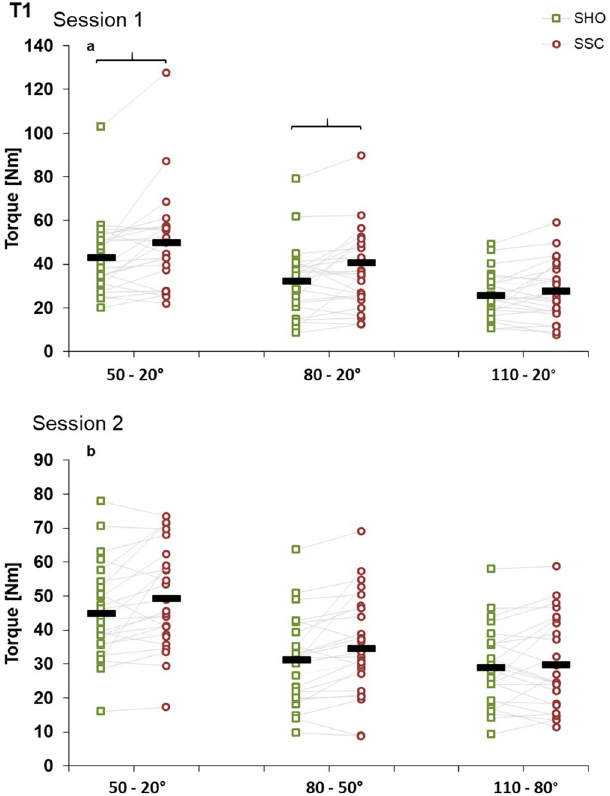
Figure 3. Mean (n = 25, thick horizontal line) (and mean of each individual subject) values of joint torque in session 1 with varying SHO- and SSC-magnitudes ( a ) and in session 2 with varying muscle–tendon unit length ( b ) at the onset of shortening (T1). Green squares represent shortening-hold conditions (SHO), whereas red circles represent stretch–shortening conditions (SSC). In the SSC condition the shortening phase was preceded by the corresponding stretch phase. Braces indicate significant ( p < 0.05) differences between SSC and the corresponding SHO